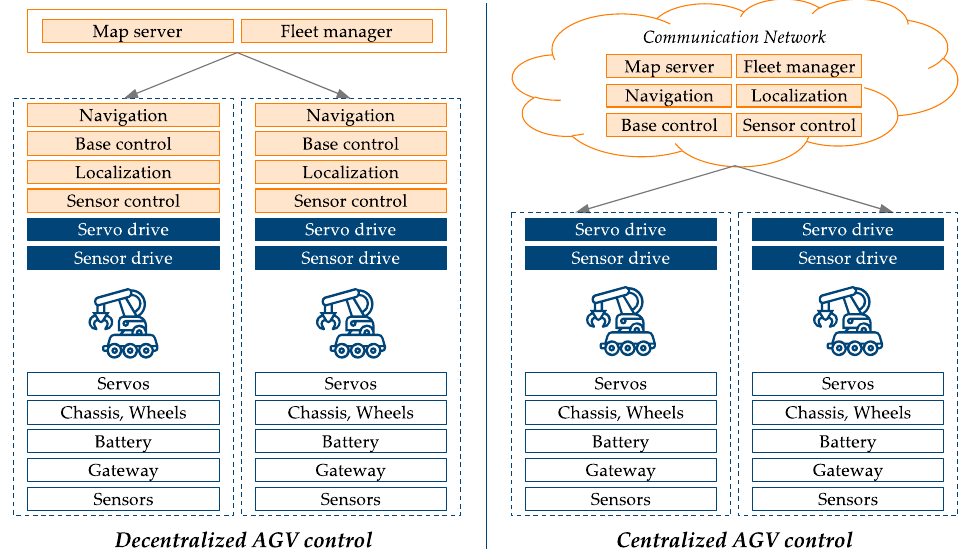
Figure 1. Difference between decentralized and centralized AGV control.